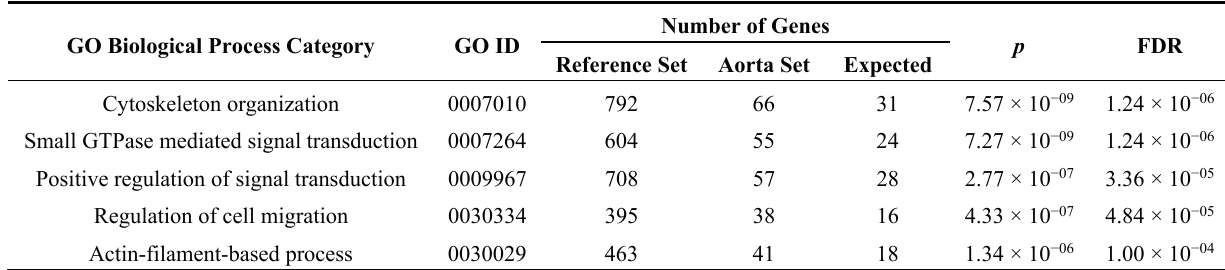
Number of Genes